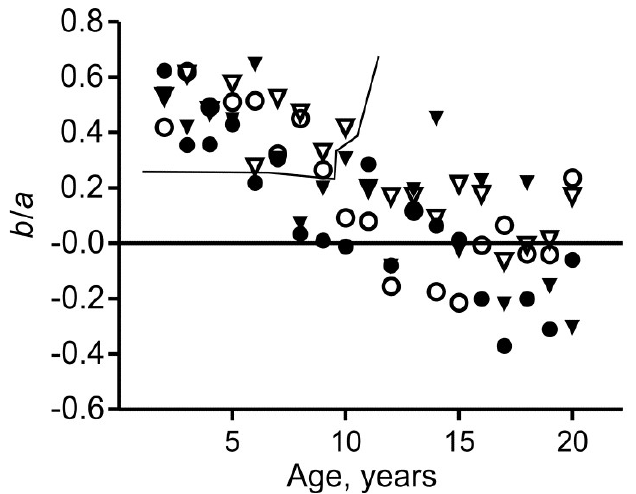
Figure 2. Values of the regression parameter b / a in Equation (2) plotted against age for white females ( ○ ), black females (●), white males ( ), and black males ( ▼ ). Values in the upper-left enclosed area differ significantly from zero ( p < 0.01). The others do not ( p > 0.05).